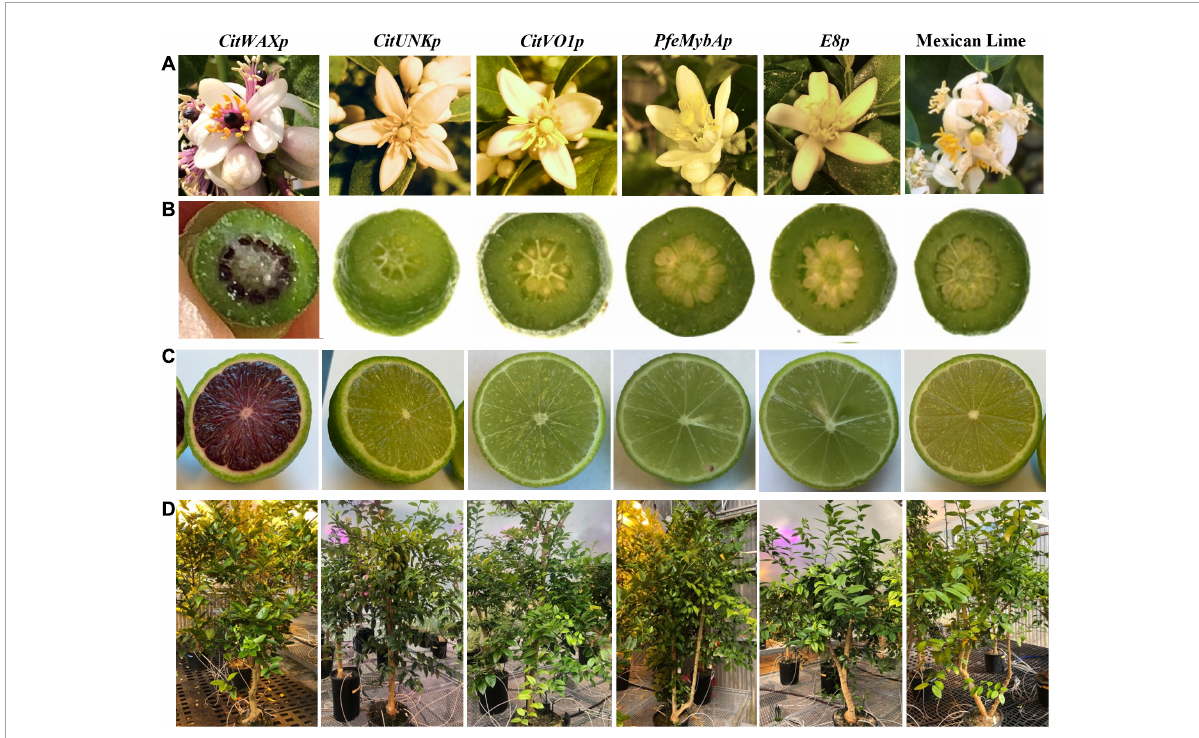
FIGURE2 Visible phenotypes within the transgenic Mexican lime trees. (A) Coloration observed in wildtype and transgenic flowers. (B) Appearance of an immature fruit approximately 2 weeks after flower petal drop. (C) Mature fruit appearance approximately 3 months after flower petal drop. (D) Representative tree from each promoter- Ruby